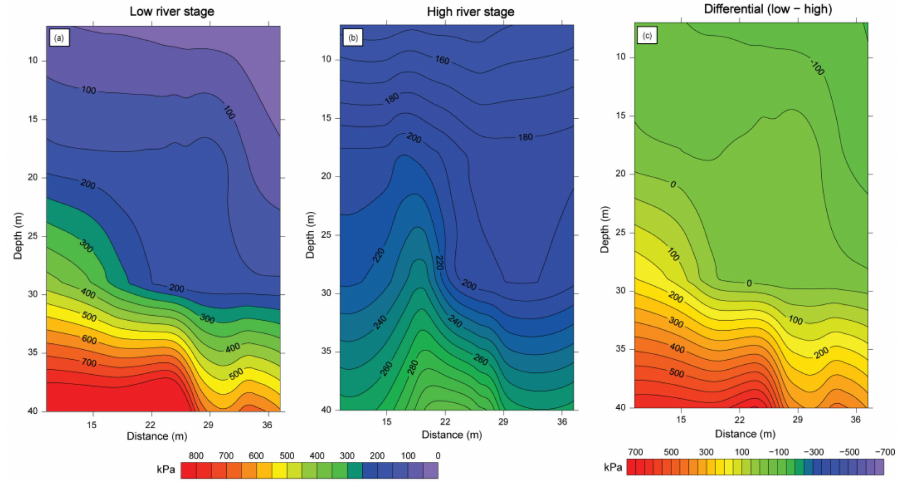
Figure 10. West side (25 m from levee toe) effective pressure profiles. Kriging-interpolated CMP interval velocities converted to effective pressure in kPa during ( a ) low and ( b ) high river stages, and the ( c ) differential effective pressure. Mean = 101 kPa and standard deviation = ± 274 kPa.